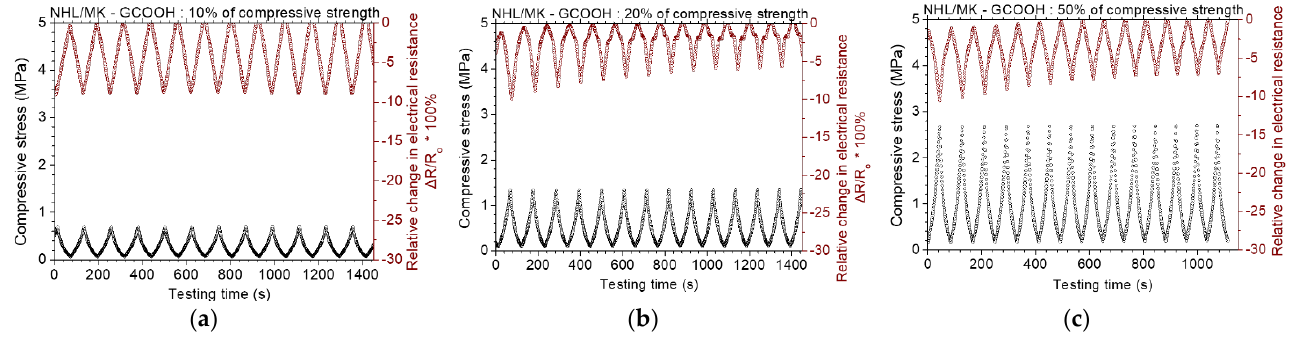
Figure 12. Cyclic, piezoresistive response of GCOOH reinforced binary paste at constant amplitude level of ( a ) 10%, ( b ) 20% and ( c ) 50% of the compressive strength of the paste.